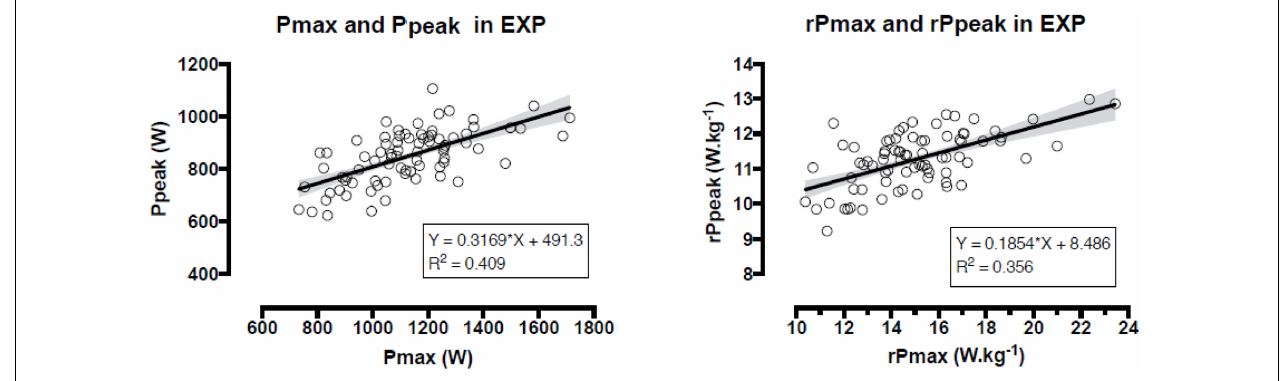
FIGURE 1 | Relationship between maximal power of the force-velocity test and peak power of the Wingate anaerobic test (both in absolute and relative to body mass values) in the experimental group. P max = absolute maximal power, rP max = relative maximal power, P peak = absolute peak power, rP peak = relative peak power.